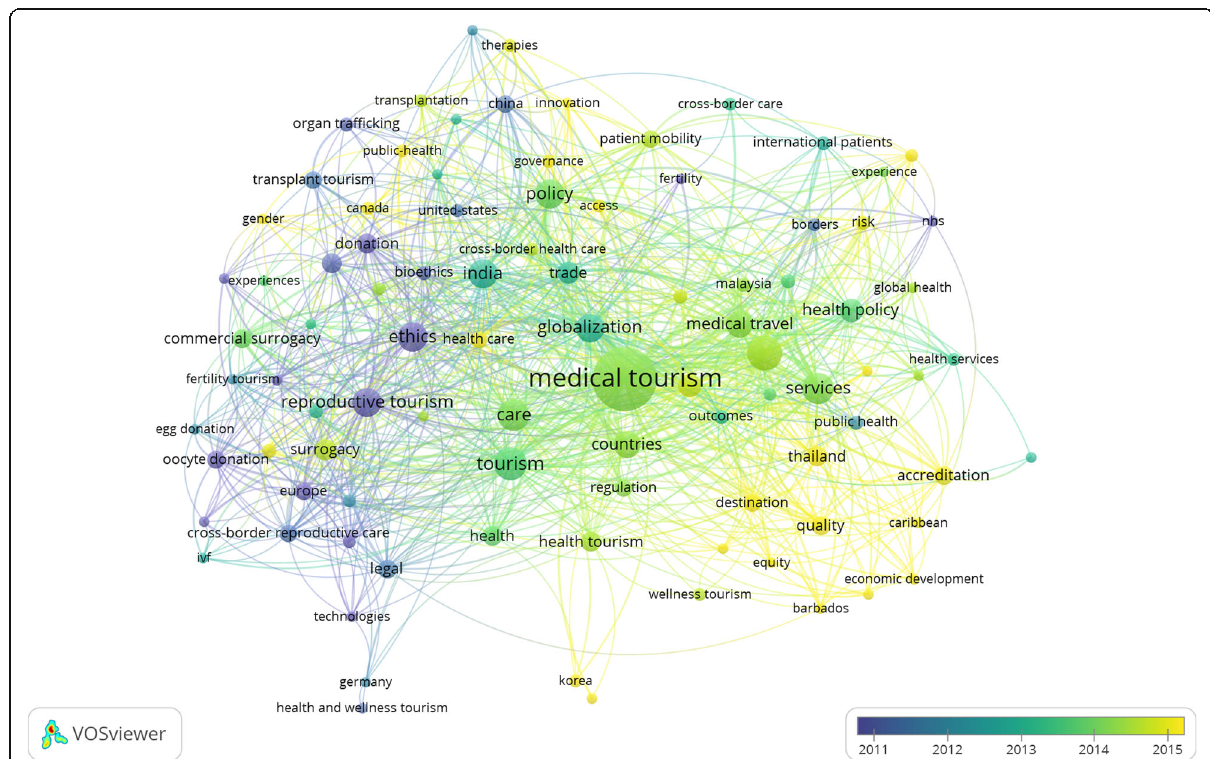
Fig. 11 Co-occurrence network of keywords in policy-related publications on medical tourism. Note: The figure shows the relatedness of author designated and auto indexed keywords (with at least three occurrences) based on how frequently they occur in the same publications. Nodes depict keywords and their linkages convey co-occurrence relationships. Larger nodes indicate keywords with more occurrences. Link strengths indicate the frequency with which they co-occur. Keywords that co-occur more frequently are clustered together. Nodes are colored based on the frequency with which the keywords occur in publications in different years. Keywords occurring with greater frequency in recent publications are colored lighter than those frequently occurring in the past